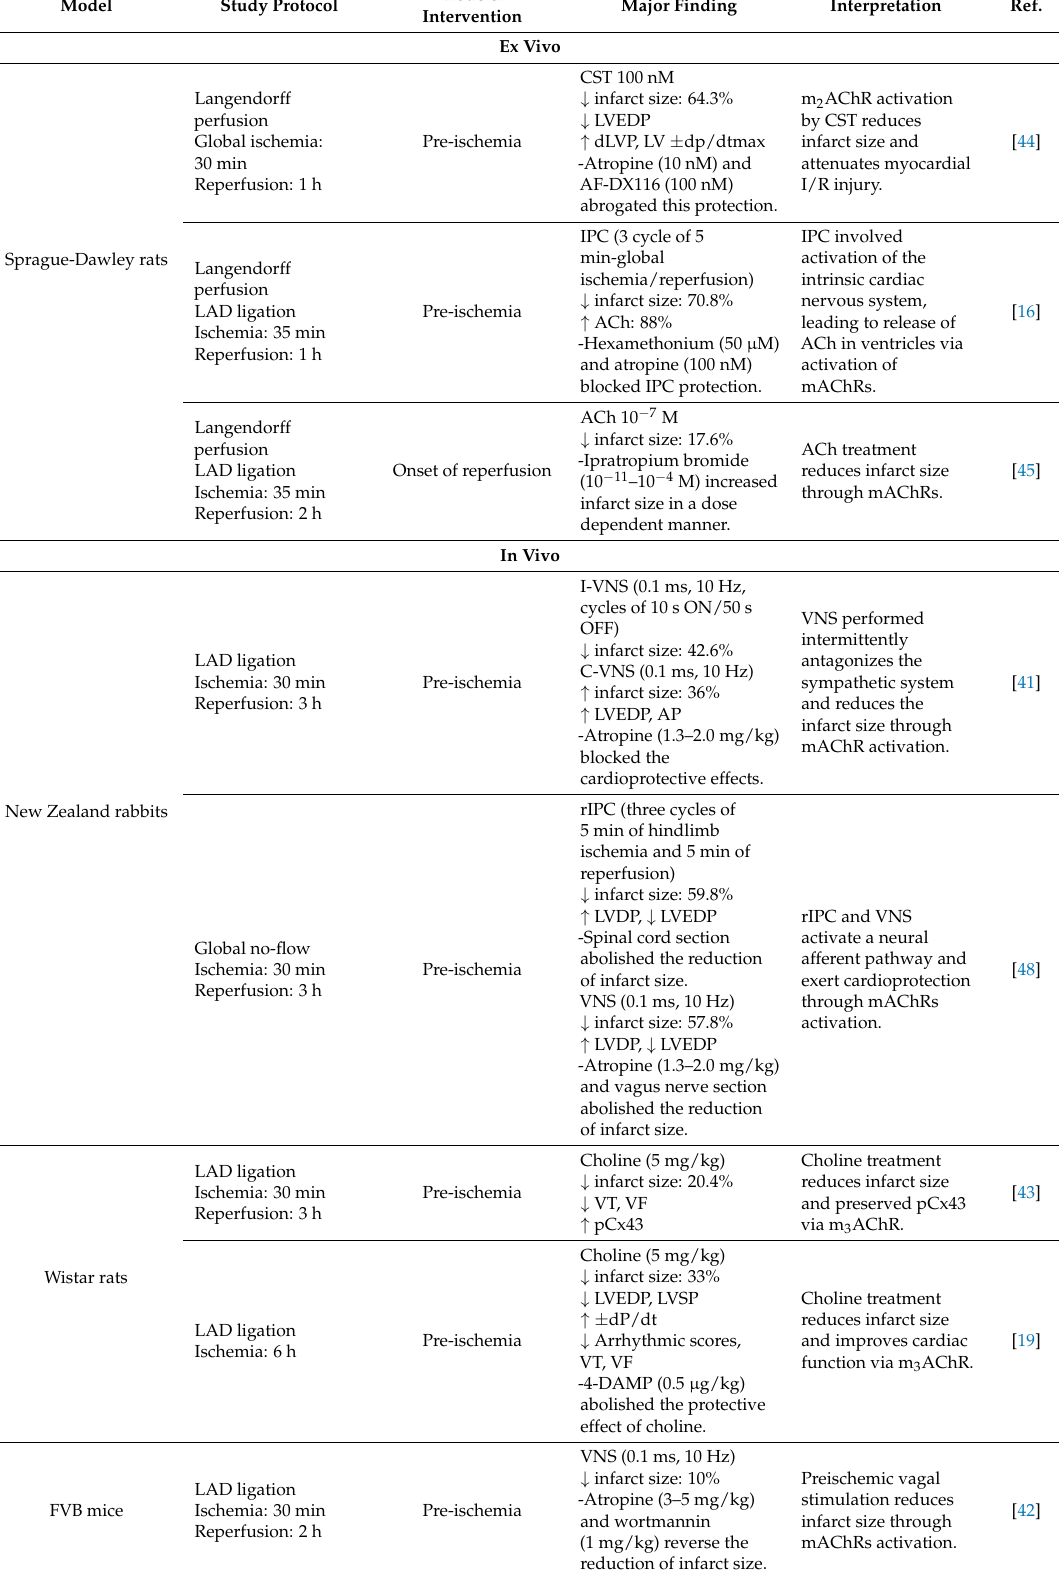
Table 1. The effects of muscarinic acetylcholine receptor activation on myocardial infarct size, hemodynamic and cardiac function in the setting of ischemia and reperfusion. Model Major Finding